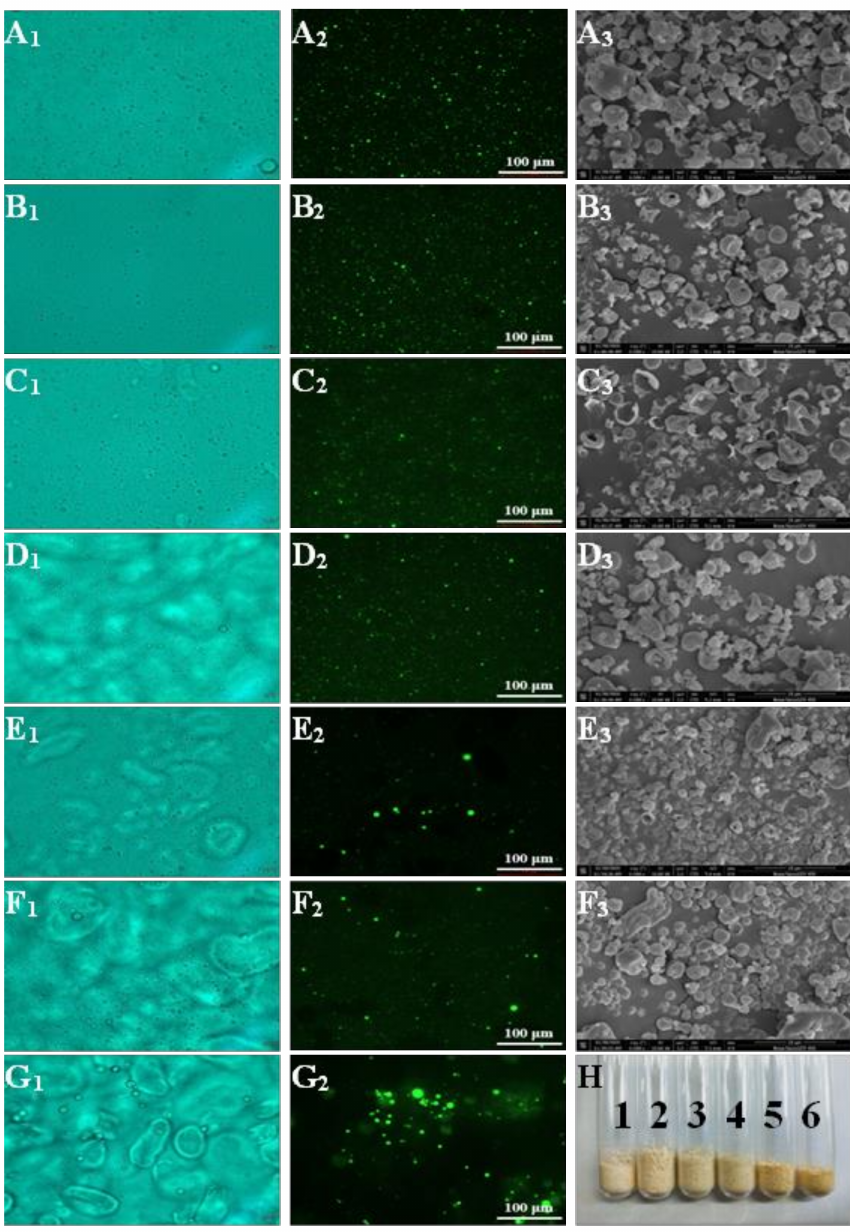
Figure 1. Optical micrographs ( × 400) (1) and fluorescence micrographs (FM) ( × 200) (2) of capsaicin emulsion. Scanning electron micrographs (SEM) ( × 6000) (3) and appearance ( H ) of microcapsules. ( A – G ) represent whey protein to citrate mung bean starch ratios of 10:0, 9:1, 7:3, 5:5, 3:7, 1:9, and 0:10, respectively. In the figure showing the appearance of microcapsules, samples 1 to 6 represent whey protein to citrate mung bean starch ratios of: 10:0, 9:1, 7:3, 5:5, 3:7, and 1:9,